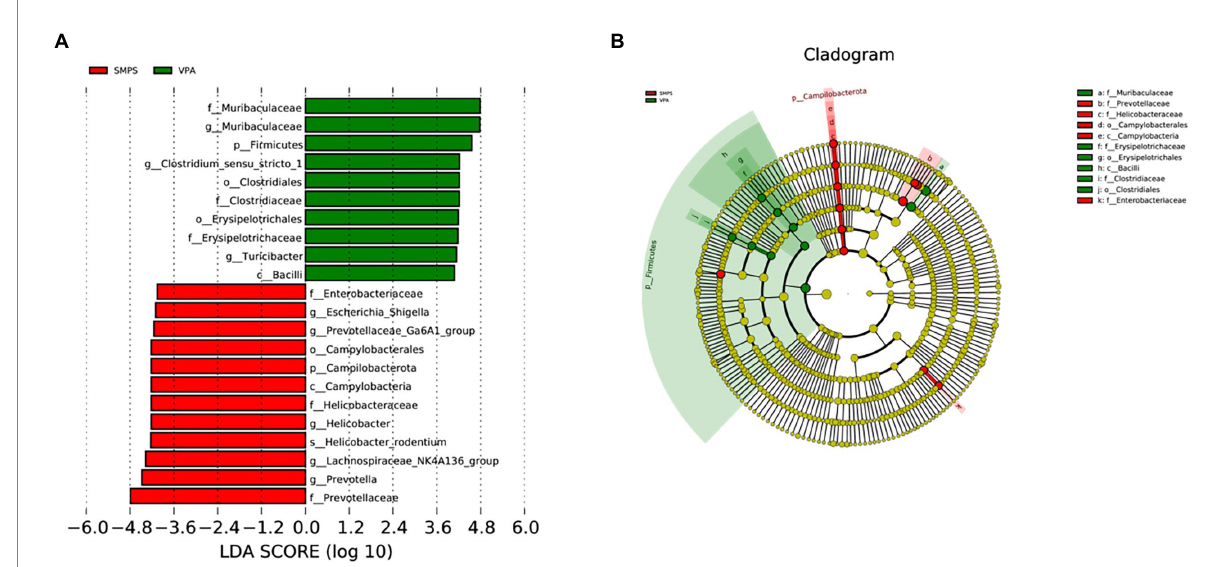
FIGURE 4 Significant bacterial taxa between the SMPS and VPA groups ( n = 8 per group). (A) Cladogram based on the linear discriminant analysis effect size (LEfSE) method, the statistical significance cutoff: absolute linear discriminant analysis (LDA) score log10 ≥ 2.0; (B) Linear discriminant analysis (LDA) coupled with LEfSE between the SMPS and VPA groups.